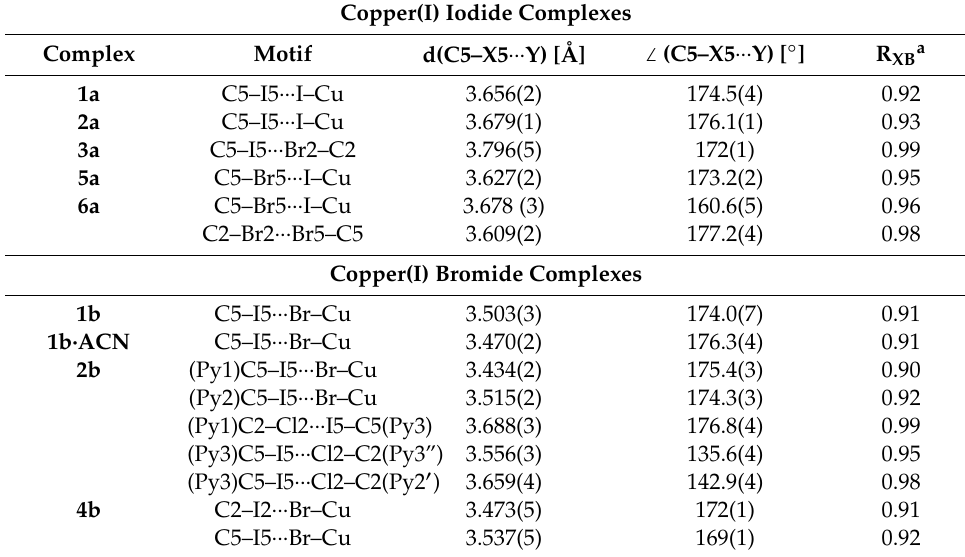
Table 1. The solid-state X-ray crystal structure C–X ··· A–Cu bond parameters of 2,5-dihalopyridine-Cu(I)